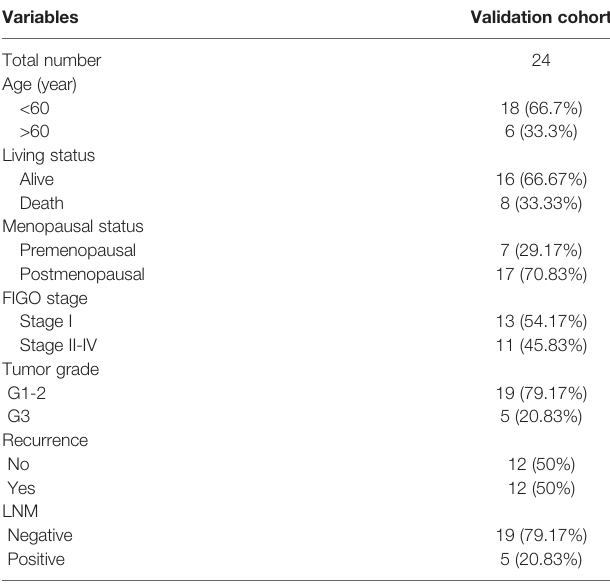
FIGO,International FederationofGynecologyandObstetrics;G,grade;LNM,lymph node